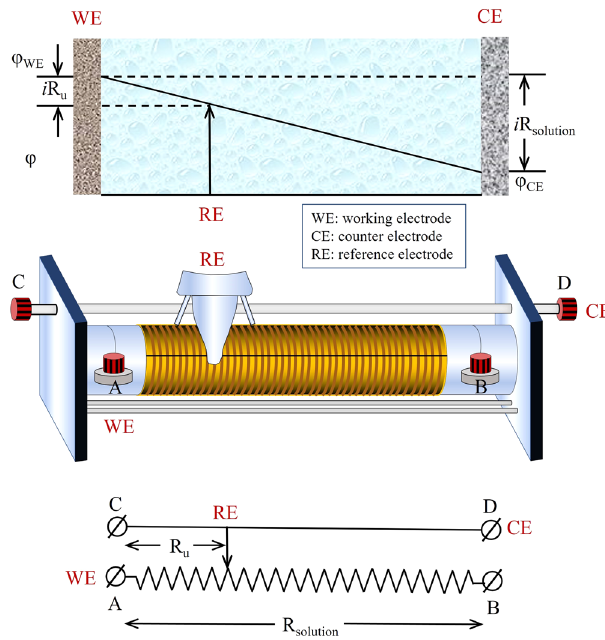
Fig. 6 Illustration of a 3-electrode system. The variable resistor is used to demonstrate the IR drop between working electrode (WE) and reference electrode (RE). CE is counter electrode; φ WE and φ CE are the potential of working electrode and counter electrode,